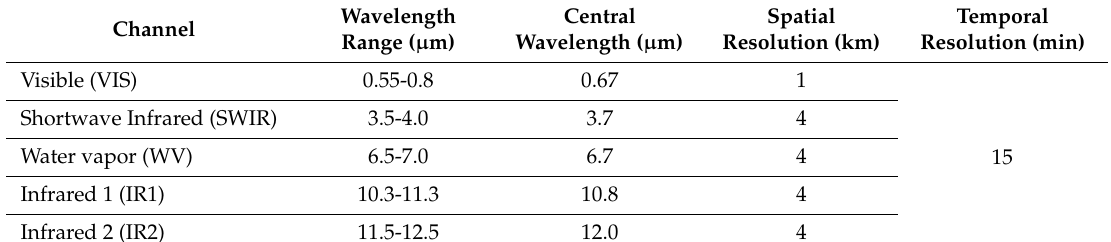
Table 1. Instrument specification of Communication, Ocean and Meteorological Satellite (COMS) Meteorological Imagery (MI) sensor. The infrared bands (SWIR, WV, IR1 and IR2) were used in this study. Channel